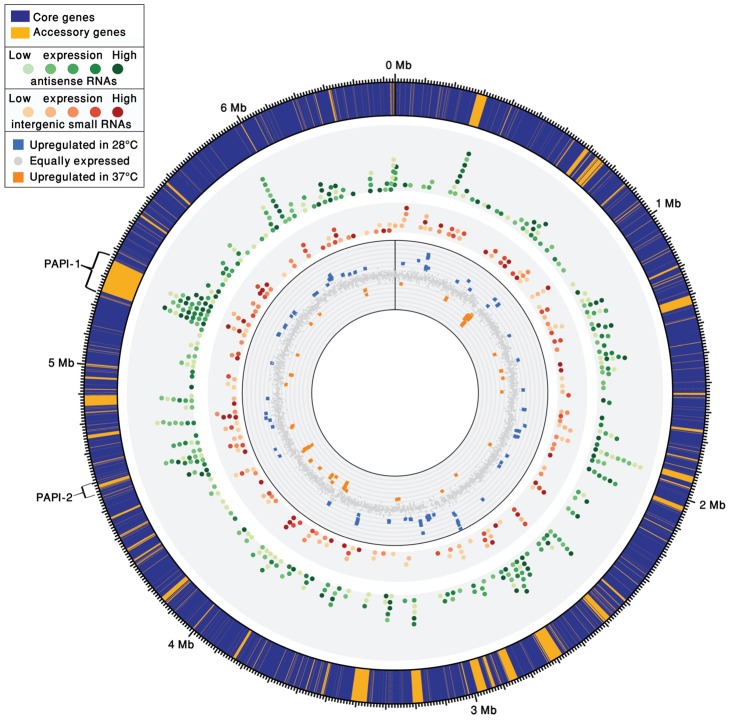
Distribution of temperature regulated genes, and segments transcribing antisense RNAs and intergenic small RNAs in the genome of P. aeruginosa PA14.The outer circle represents the core (blue) and accessory genes (yellow) as defined previously [9]. The innermost two circles represent genes that were differentially expressed at 28°C and 37°C (blue and orange, upregulated in 28°C and 37°C, respectively); the middle two circles show the expression of sRNAs from intergenic regions (red dots) and asRNAs (green dots). For each category, relative ranking of expression was grouped into five color-coded bins (darker colors represent higher expression).